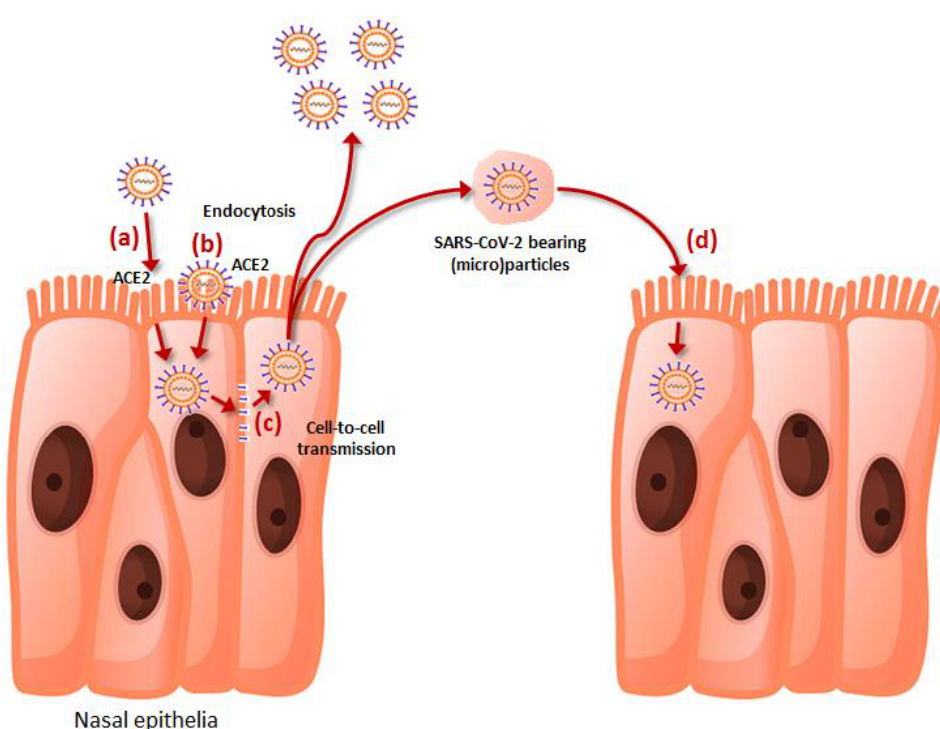
Figure 1. The pathways of epithelial cell penetration by SARS-CoV-2, encompassing ( a ) direct attachment to angiotensin converting enzyme 2 (ACE2) on host cell surface, ( b ) cathepsin-dependent endocytosis; ( c ) cell-to-cell transmission, and ( d ) fusion of SARS-CoV-2-bearing extracellular particles with host cell membrane.